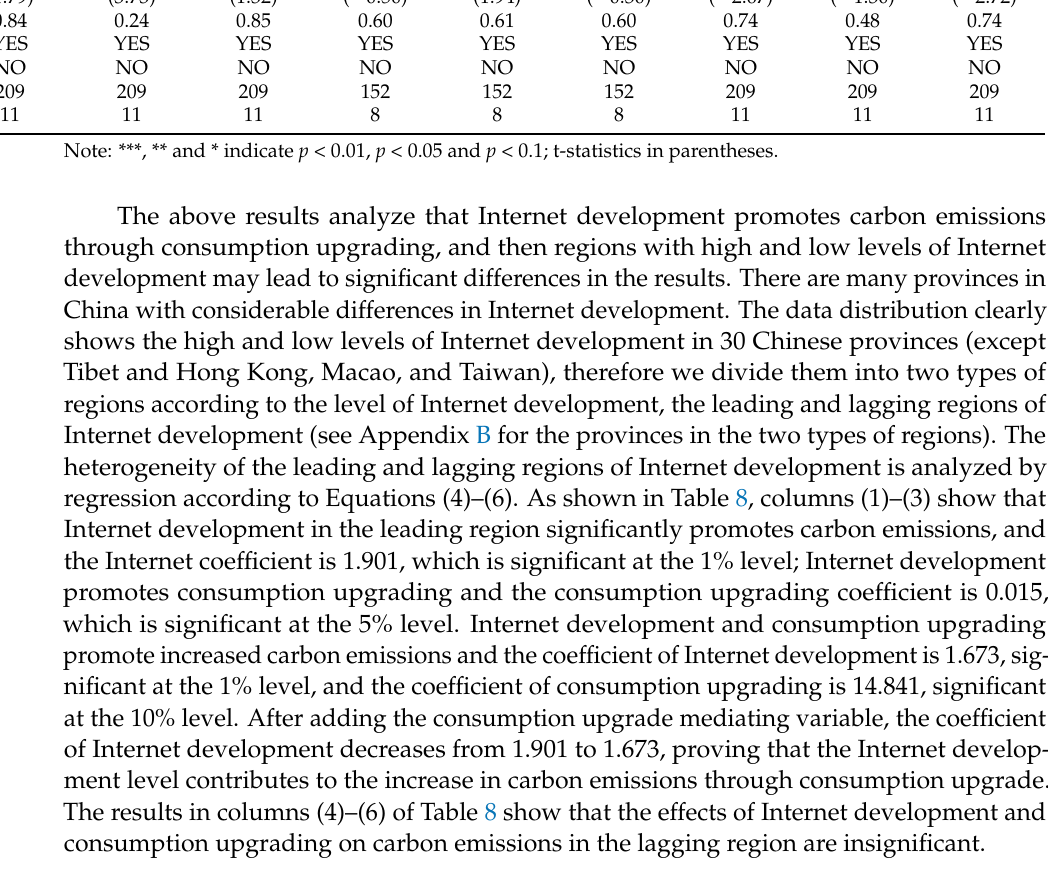
Table 8. Regional heterogeneity analysis of Internet development